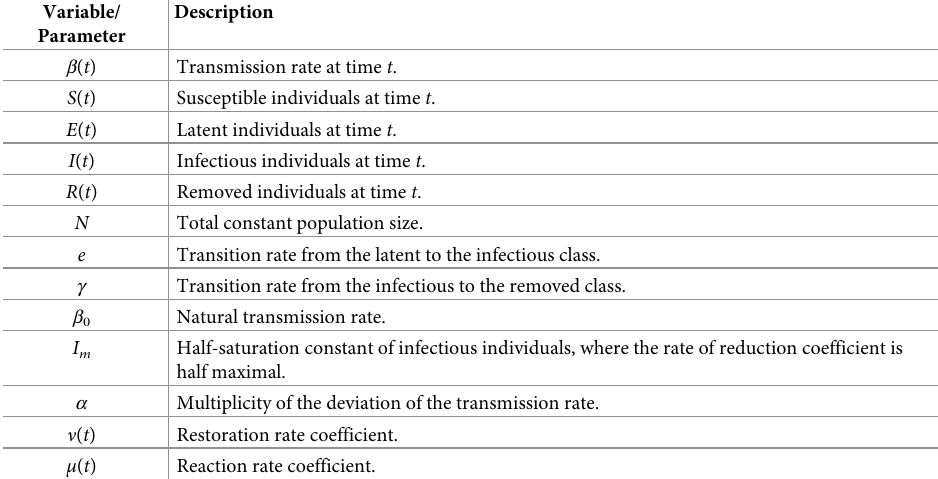
Table 1. Description of variables and parameters from the model in system